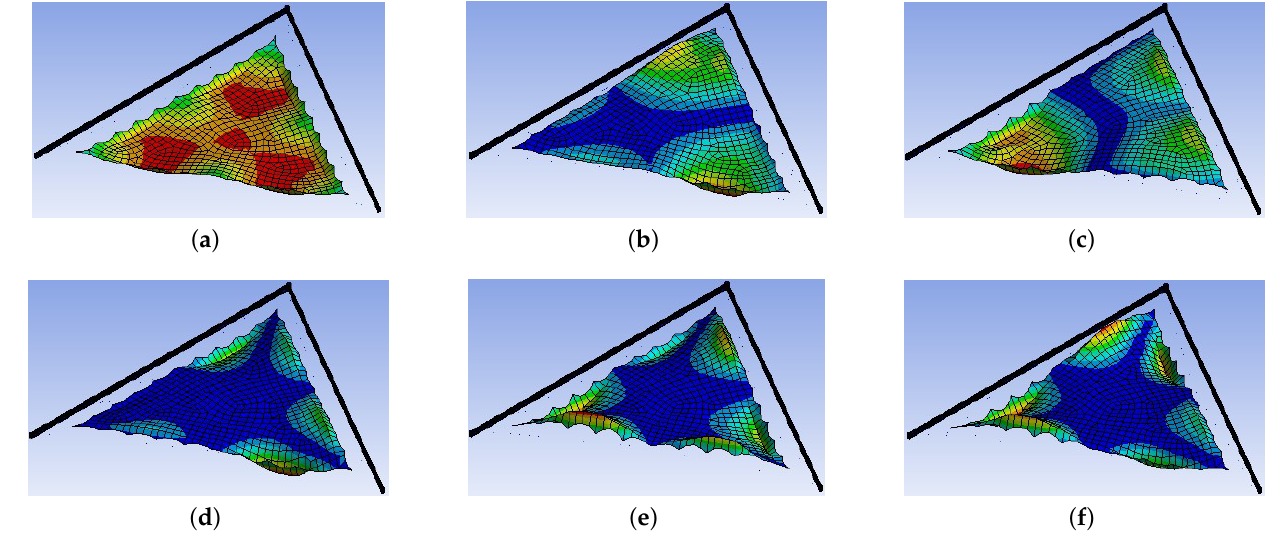
Figure 7. The first 6-order mode shapes: ( a ) 1st, ( b ) 2nd, ( c ) 3rd, ( d ) 4th, ( e ) 5th and ( f )